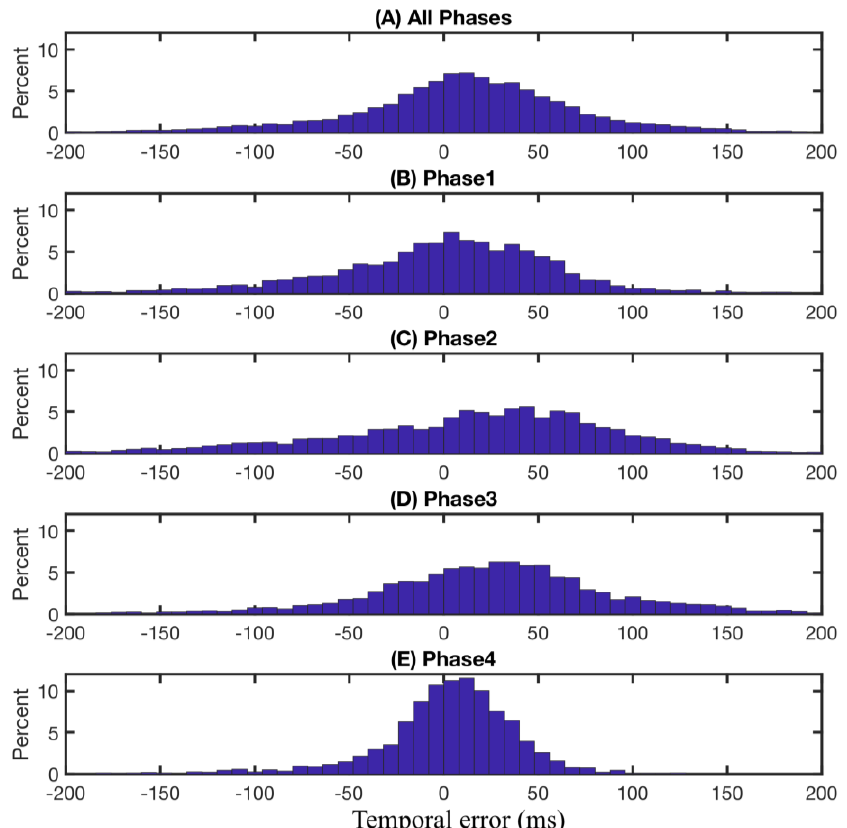
Figure 6. Time difference (temporal error) between detected gait phase events and manually annotated gait events. Positiveness of the durations means the predicted events proceed the corresponding observed events. ( A ) overall temporal error considering all four gait phases across nine subjects and all three speeds. ( B – E ) temporal errors for each gait phase across all nine subjects and all three speeds.